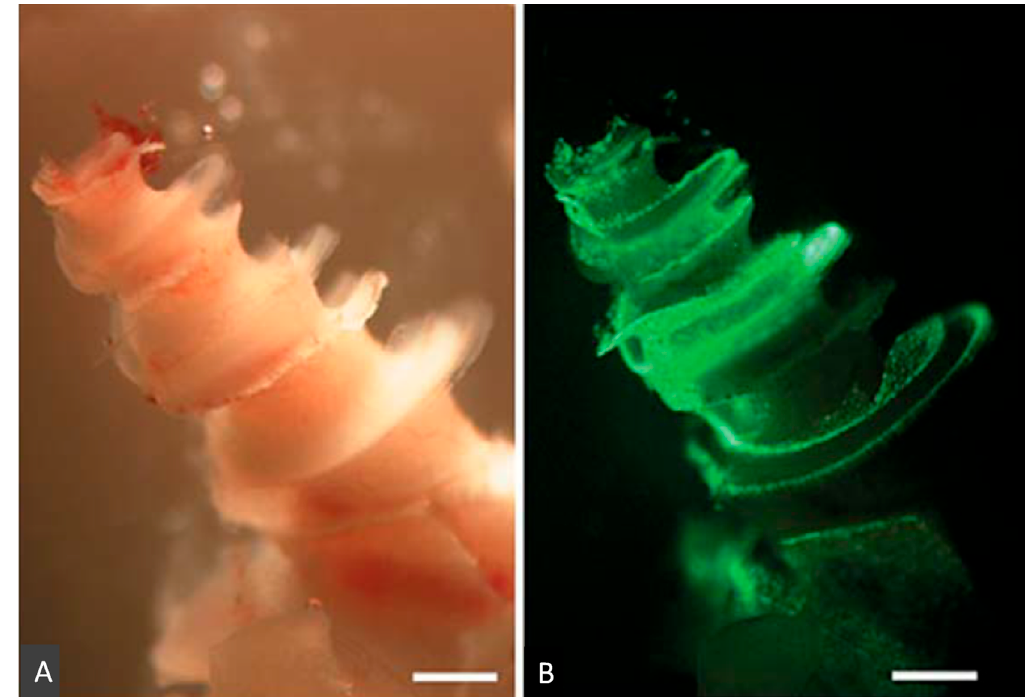
Figure 2. Photomicrographs of whole-mounted guinea pig cochlea showing the distribution of GFP-fusion protein after injection of GFP-fused Sendai virus vector (GFP-SeV/ ∆ F) into the scala media. Light ( A ) and fluorescent ( B ) images of the cochlea of a SeV-inoculated ear. Scale bars: 1000 μ m (This figure was cited by reference [12] and permitted by S. Karger AG, Medical and Scientific Publishers.).